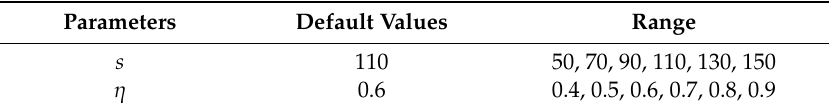
Table 2. Adjustment of the parameters.